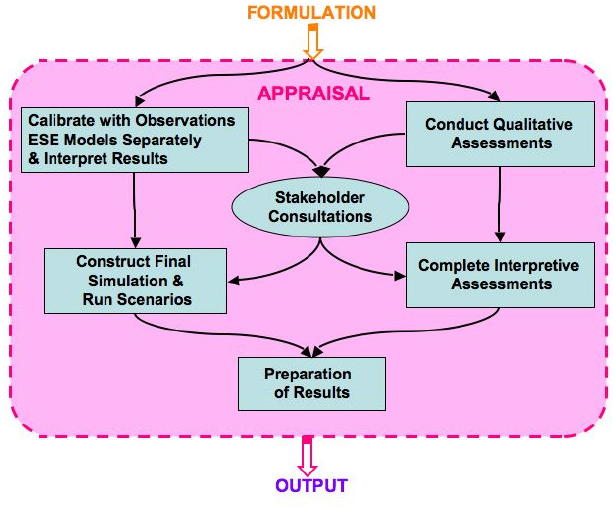
Fig. 8 . Diagram of the activities and products for